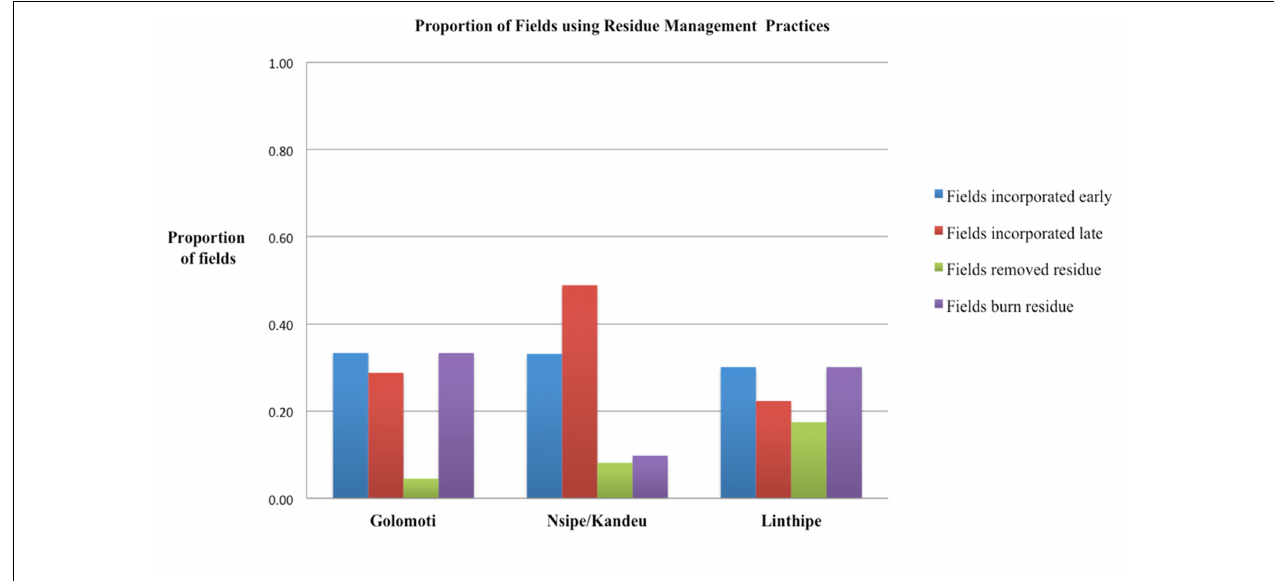
FIGURE 5 | The proportion of fields using a specific residue management practice presented in terms of low, medium, and high potential sites in Central Malawi. Based on survey conducted July of 2013, field n =